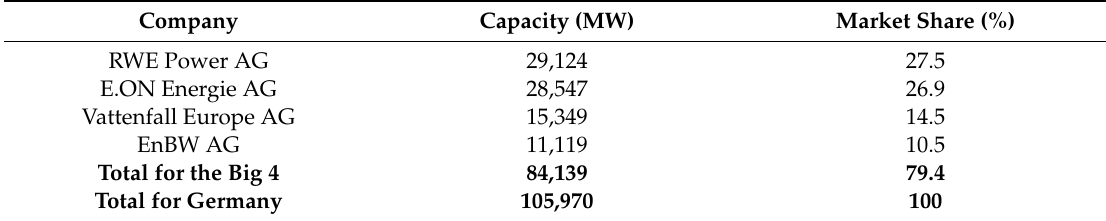
Table 1. Electricity generation capacity and market share of Germany’s four big energy providers in 2005